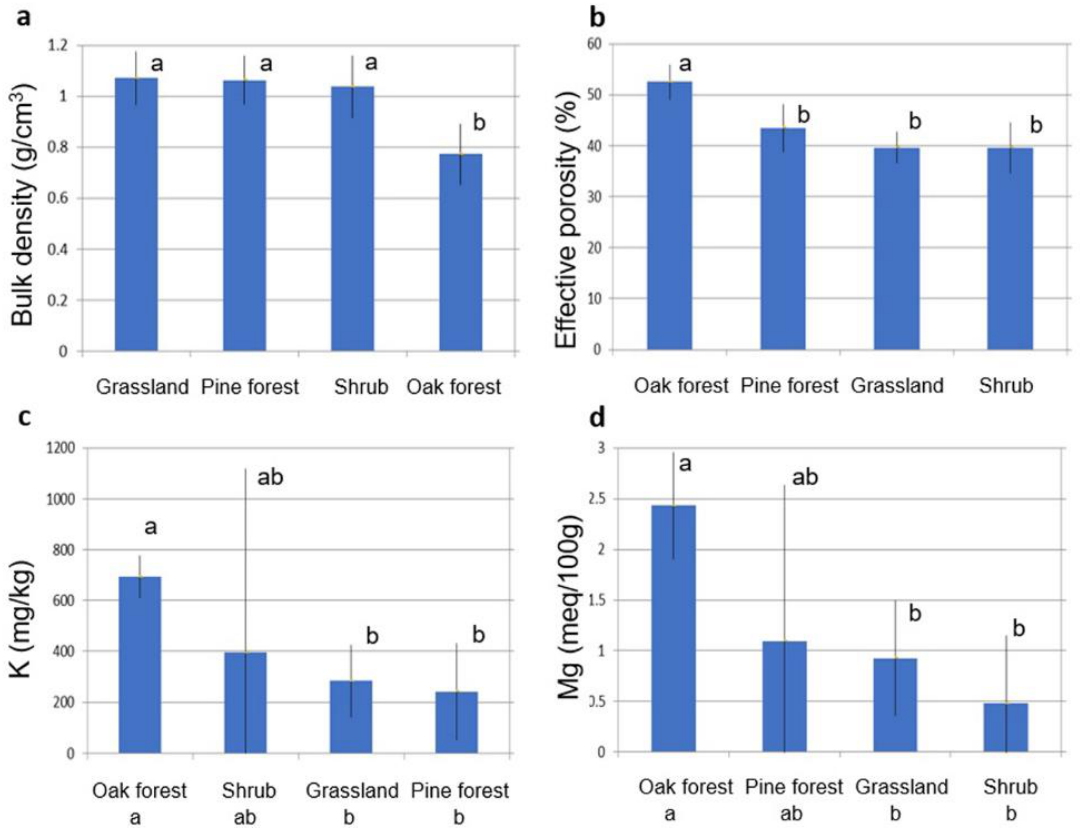
Figure 5. Mean plot of the bulk density: ( a ) bulk density, ( b ) effective porosity, ( c ) K content, and ( d ) Mg content for the vegetation types. Error bars represent 95% confidence intervals. Different letters denote statistically significant differences, α = 0.05.